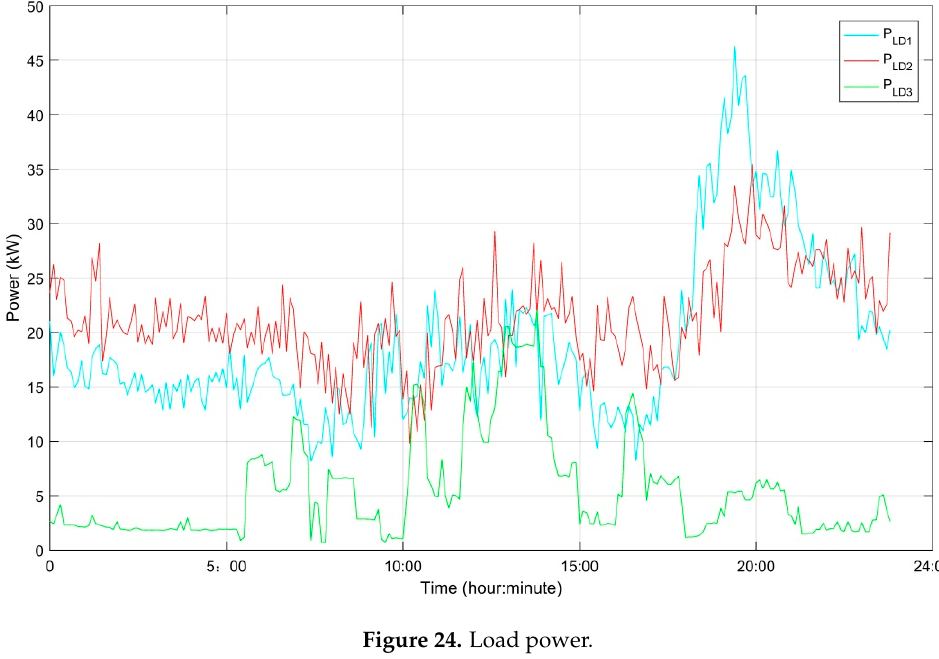
Figure 24. Load power.